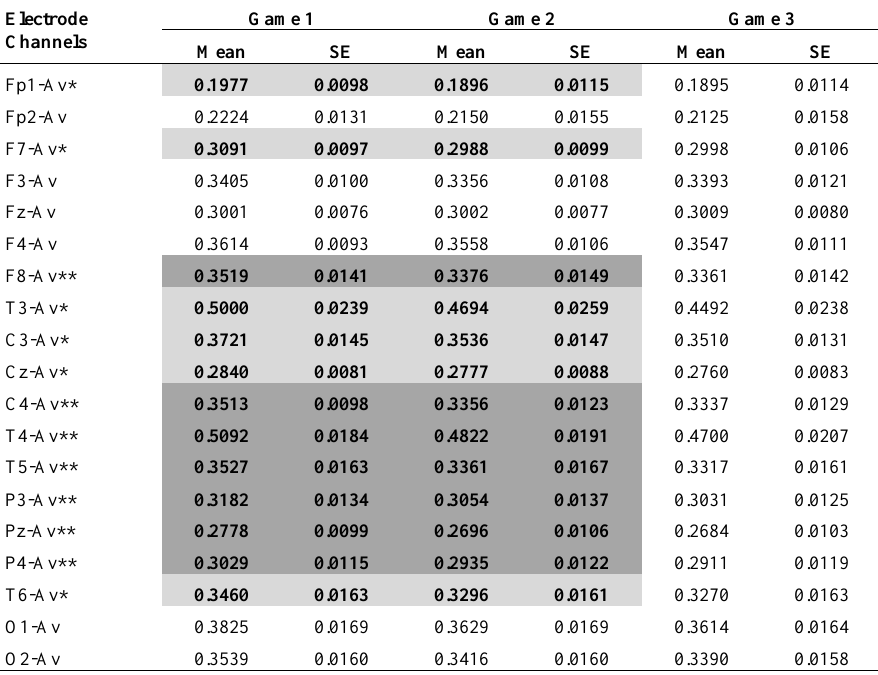
Table 2. The beta-band relative power between different games' segments (*p<0.05,